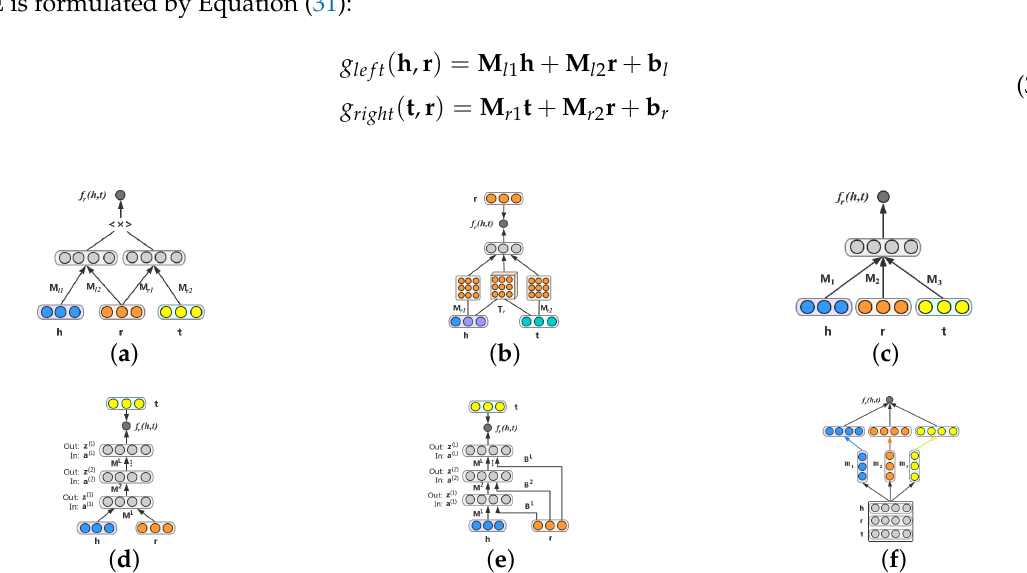
Figure 4. Illustrations of neural network-based-based models. ( a ) SME, ( b ) NTN, ( c ) MLP, ( d ) NAM, ( e ) RMNN, ( f ) ConvKB. SME (bilinear) is formulated in Equation